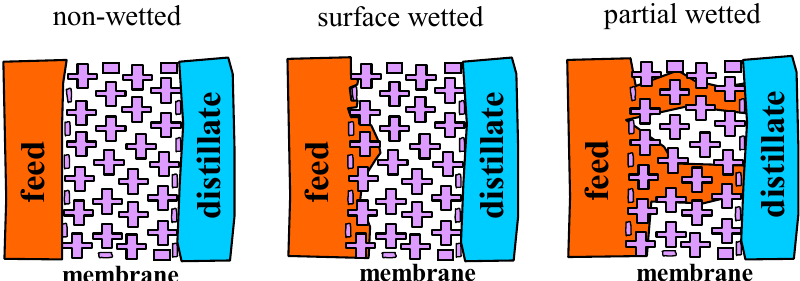
Figure 1. The stages of hydrophobic membrane wetting during the membrane distillation (MD) process.